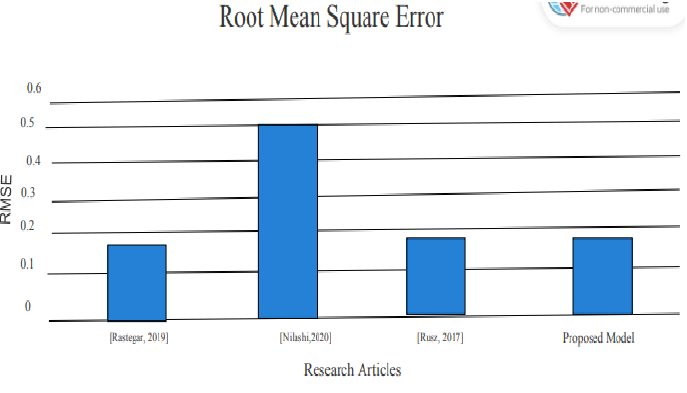
Figure 6. RMSE comparison [3,4,29].